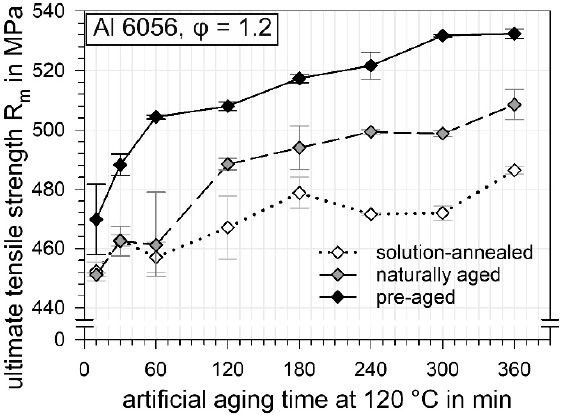
Figure 4. Ultimate tensile strengths of the 6056 aluminum alloy in solution-annealed, pre-aged and naturally-aged conditions as a function of the artificial aging time after linear extrusion with φ = 1.2. Depicted here are the mean, minimum and maximum values of each tensile strength. The strength of the pre-aged condition is significantly higher when compared with the solution-annealed or naturally-aged conditions.